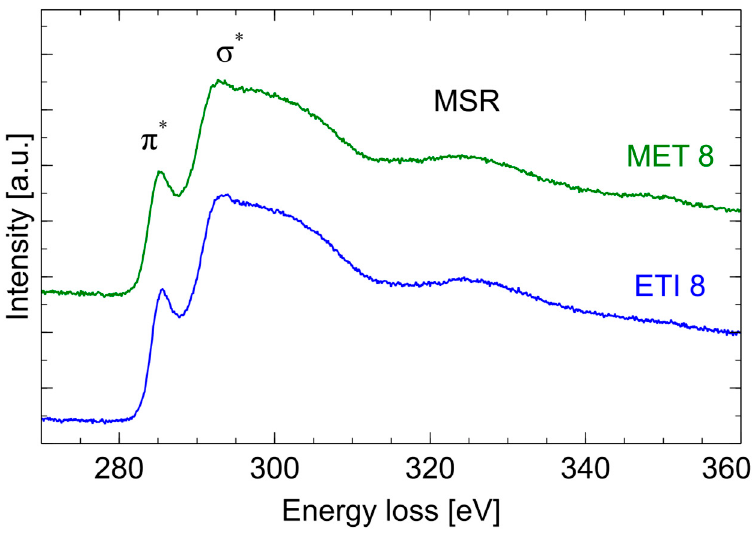
Figure 6. Comparison of the shape of the absorption curves CK. The percentage of sp 2 hybridized carbon atoms was determined by analyzing the shape of the absorption curve CK. For the obtained core-loss spectra background was subtracted and the multiple scattering was then removed by Fourier-ratio deconvolution with the low-loss spectrum obtained for exactly the same region of the sample. The maximum of the π * peak was fixed at 284.5 eV to minimize systematic error from peak position. To determine the ratio of (planar) sp 2 bonded carbon to total carbon, the spectra were fitted by five Gaussian peaks (Figure 7) [8]: − the first Gaussian (G1) centered at 284.5 eV (C=C π * component); − the second Gaussian (G2) centered at 291.75 eV (C–C σ *component); − the third Gaussian (G3) centered at 297.75 eV (C=C σ *component); − two additional (G4 and G5) 286–288 eV (due to the presence of additional heterospecies or the presence of a non-planar sp 2 -bonded carbon